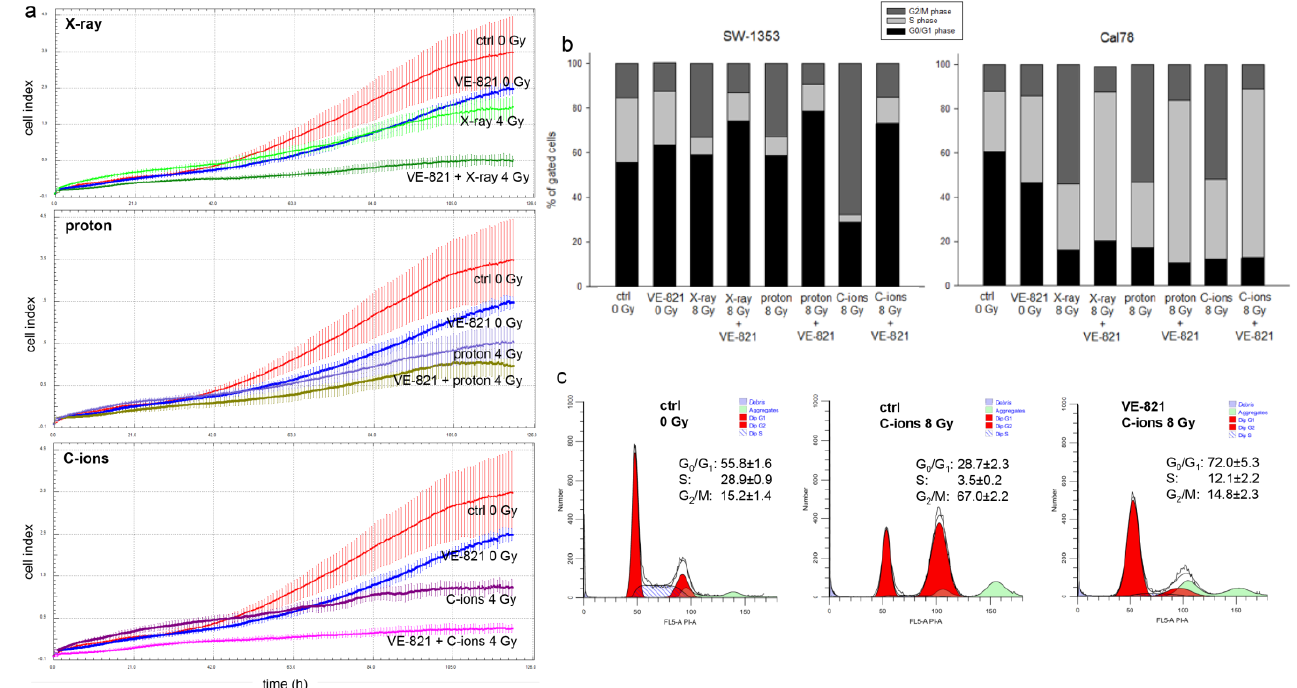
Figure 4. Proliferation and cell cycle distribution after the combined treatment of VE-821 and 4 Gy X-ray/proton/C-ions IR. ( a ) xCELLigence real-time proliferation analysis (red: non-IR controls; blue: VE-821 0 Gy; light green: X-ray 4 Gy; dark green: VE-821 + X-ray 4 Gy; purple: proton 4 Gy (LET 2.9 keV/μm); dark yellow: VE-821 + proton 4 Gy; dark magenta: C-ions 4 Gy (LET ca. 55 keV/μm); magenta: VE-821 + C-ions 4 Gy) shows the additive effect of the combined treatment, with the strongest effect with C-ions IR in SW-1353 cells. ( b ) Chondrosarcoma cells were analyzed using flow cytometry 24 h after combined treatment with 10 µM VE-821 and 8 Gy X-ray/proton/C-ions IR. The corresponding statistical evaluation is shown in stacked bar charts ( n = 4). ( c ) Representative original tracks of non-IR control cells (ctrl), VE-821 0 Gy, and after 8 Gy C-ions IR without and with VE-821 treatment are shown. Table 1. Cell cycle distribution of chondrosarcoma cells 24 h after combined treatment of 10 µM VE-821 and 8 Gy X-ray/proton/C-ions IR ( n = 4; mean ± SD; n.s.: not significant; * p < 0.05, ** p < 0.01, *** p < 0.001 represent significances of the VE-821 effect; # p < 0.05, ## p < 0.01, ### p < 0.001 represent significances of irradiation).